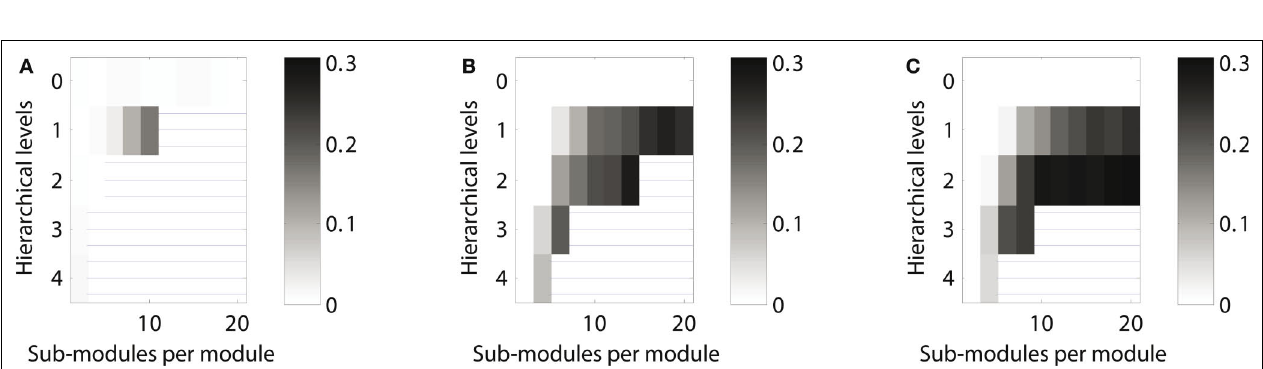
FIGURE 5 | Scaling of optimal confi gurations with network size for constant global edge density. Proportion of cases showing LSA (averaged over 200 generated networks for each confi guration) in (A) “rat-size” networks with 300 columns, (B) “cat-size” networks with 4,150 columns, (C) “macaque-size” networks with 11,000 columns.